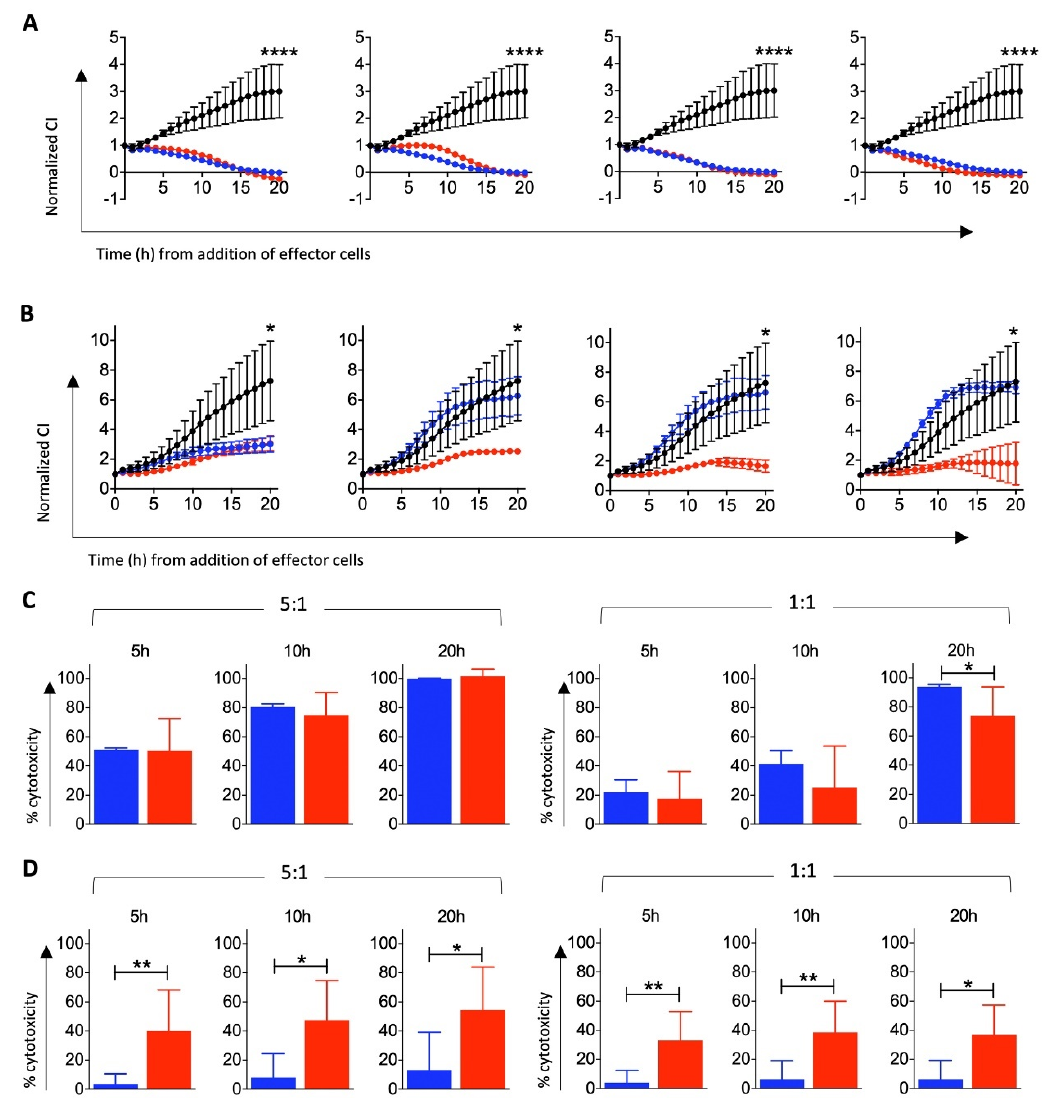
Figure 5. HSC-derived T cells induce killing of ovarian cancer cells in vitro. T cells were generated from HSCs for 42 days and transferred to 6F media in the presence of anti-CD3/CD28 DynaBeads ® for the first 3–4 days of a 7-day culture, to induce polyclonal T cell activation. ( A ) OVCAR-3 and ( B ) MES-OV target cells were co-cultured with the HSC-derived T cells (red) or T cells isolated from CBMCs (blue) at an effector to target (E:T) ratio of 5:1. Target cell alone controls (black) were maintained in parallel. Their cytotoxicity response was monitored in real time using xCELLigence, where a decrease in Normalized Cell Index (CI) is indicative of target cell death relative to target cells alone. Each plot is representative of a single donor performed in technical triplicate. Efficiency of ( C ) OVCAR-3 and ( D ) MES-OV target cell killing was quantitated at 5 h, 10 h and 20 h and presented as average % cytotoxicity ± SD pooled from 4–8 biological replicates. * p ≤ 0.05, ** p ≤ 0.01, **** p ≤ 0.0001. Abbreviations: CI, Cell Index; h,